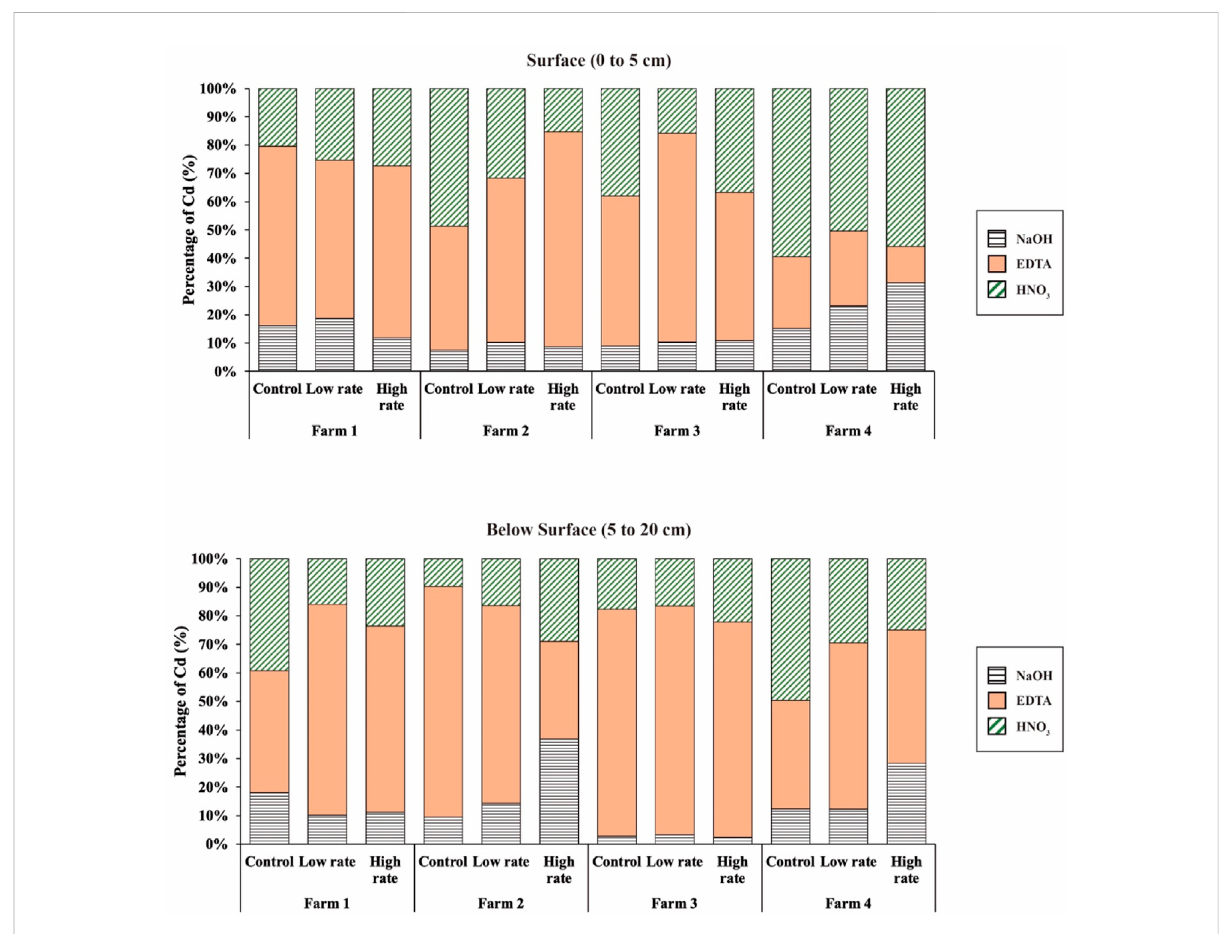
FIGURE 3 Soil-Cd expressed in percentage from different soil fractions at two depths in four fi eld trials located in Ecuadorian cacao